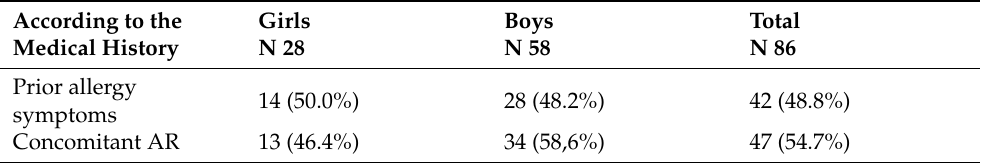
Table 1. Children with atopic symptoms and or concomitant AR in the main study group. According to the Medical